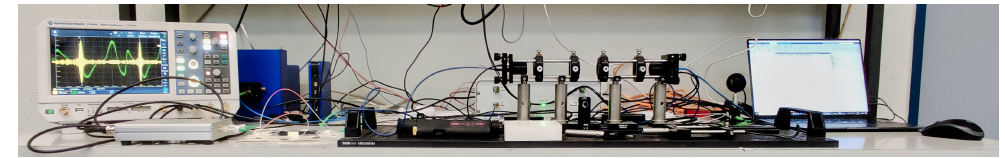
Figure 5. Photograph of the measurement